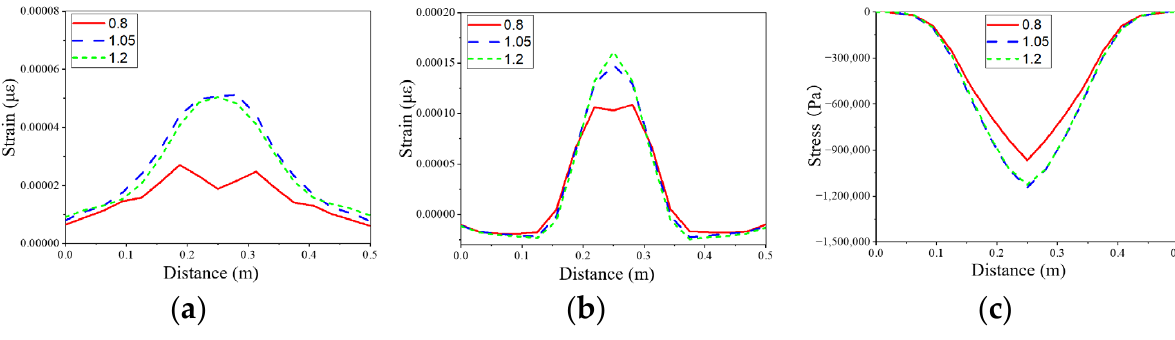
Figure 16. The dynamic responses under different tire pressure. ( a ) The longitudinal strain at the bottom of SFP. ( b ) The transverse strain at the bottom of SFP. ( c ) The vertical stress at the bottom of AC.